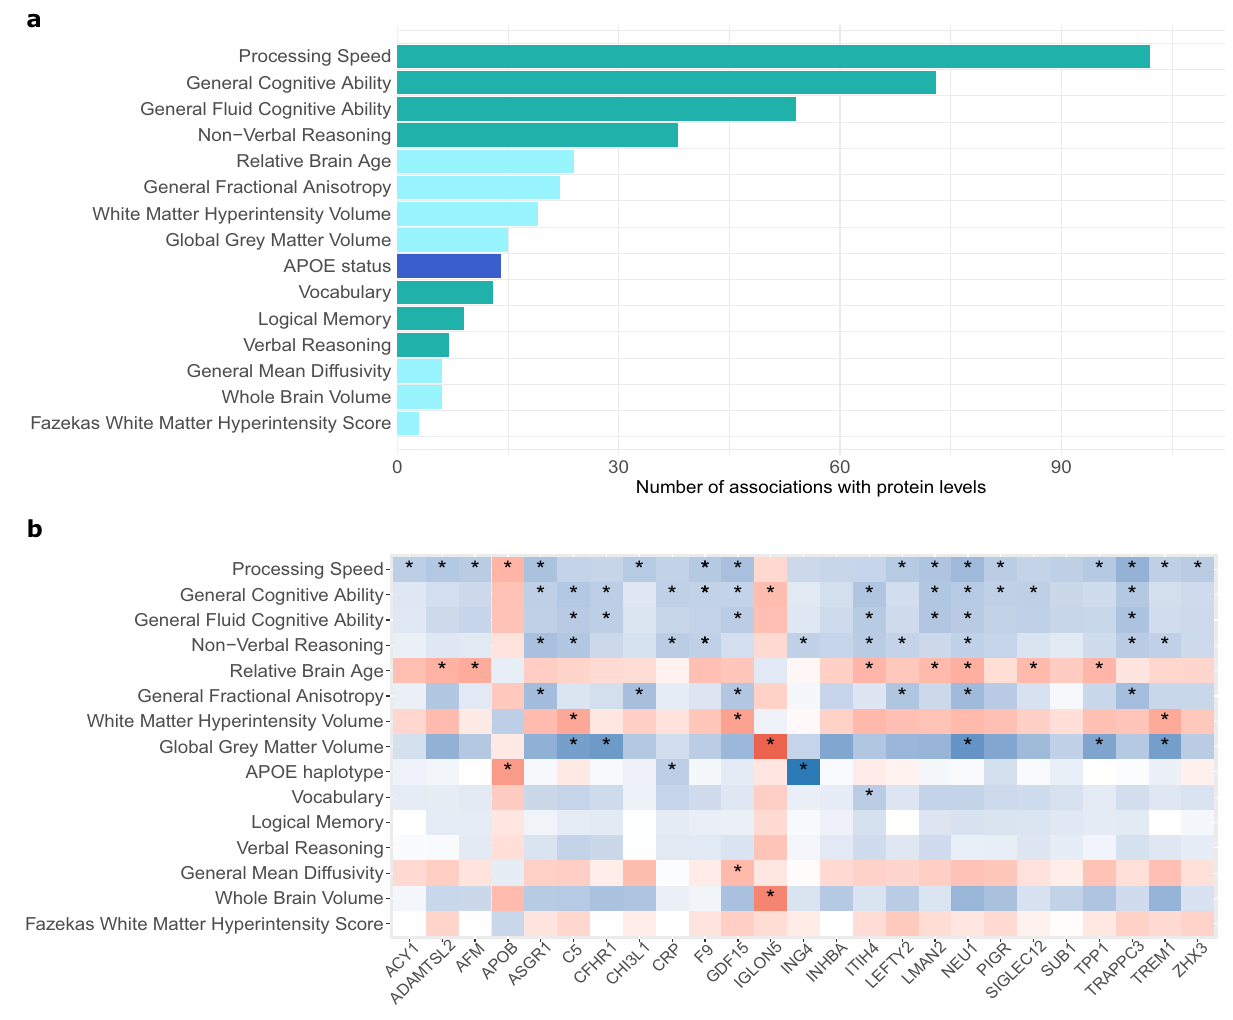
Fig. 4 | Phenome-wide associations studies(PheWAS) of4058 plasma proteins and brain health. a Number of protein marker associations with P <3.5×10 − 4 for each of the 15 traits related to brain health in the phenome-wide protein associa- tionstudies(proteinPheWAS).Thesestudiesincludedamaximumsampleof1065 individuals with protein measurements from Generation Scotland and tested for associations between 15 phenotypes and the levels of 4058 plasma proteins via linearmixed effects regression. Cognitive score (green), brainimaging (light blue) and APOE e4 status (dark blue) associations are summarised. Full summary sta- tistics for the 405 associations with P values are presented in Supplementary Data 17. All associations were generated through linear regression and